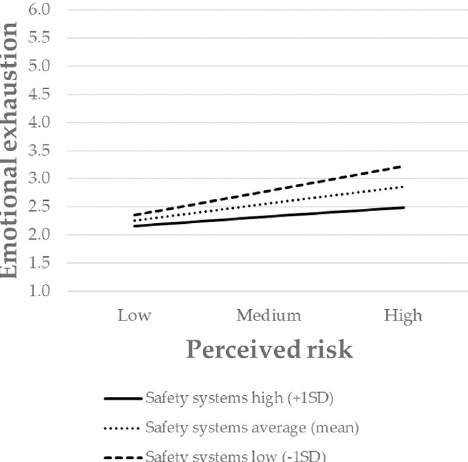
Fig 2. The moderating role of safety systems in the relationship between the perceived risk of being infected at work and emotional exhaustion. Perceived risk = perceived risk of being infected at work. SD = standard deviation.